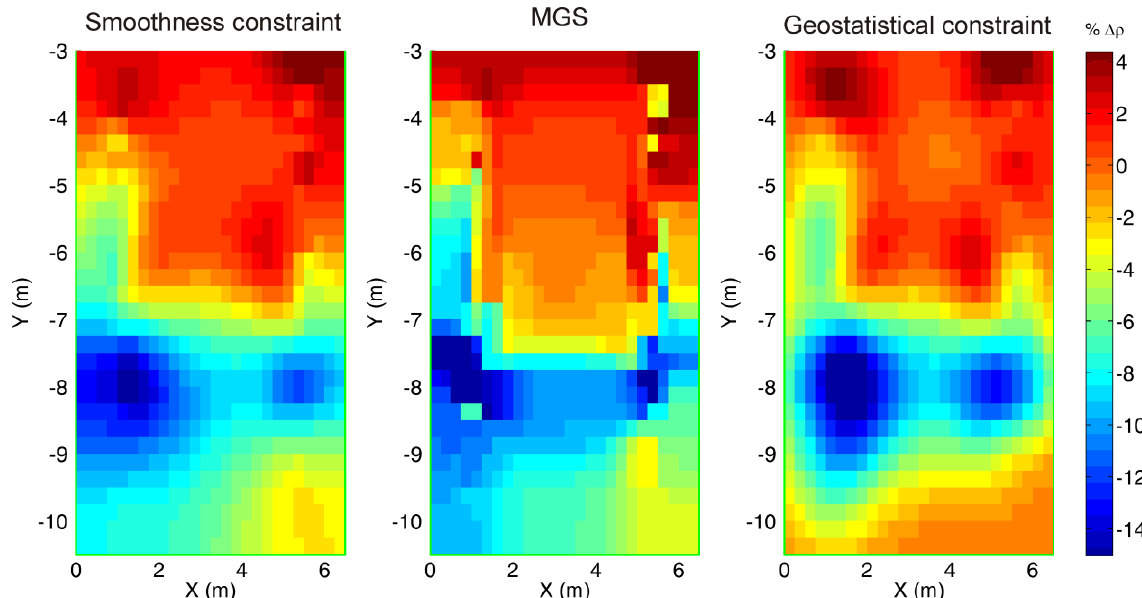
Figure 3. Tomographies of changes in bulk electrical resistivity after injecting hot water (3 m 3 /h at a mean temperature of 38 °C). The background tomography is the one shown in Figure 2. Hot water injected in a well located at 8m upgradient, on the whole aquifer thickness, can be seen as negative resistivity changes (blue). It is preferentially found in the deeper part of the aquifer because groundwater flows preferentially in this high hydraulic conductivity zone (gravel). This figure compares time-lapse inversions using the standard smoothness constraint regularization ( left ), minimum gradient support ( middle ) and geostatistical inversion ( right ) (modified after